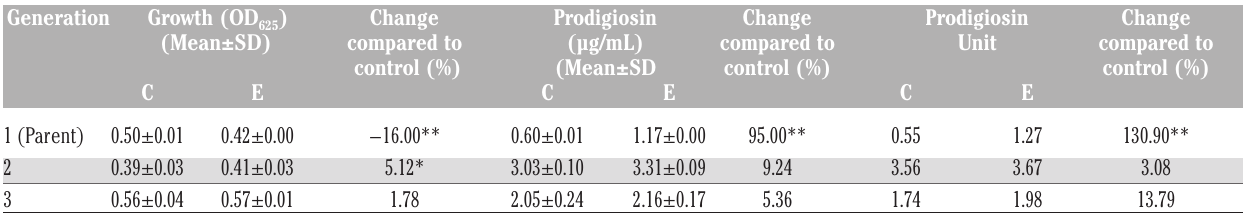
Table 5. Loss of prodigiosin overproduction by daughter generations of VHVS_PR2.